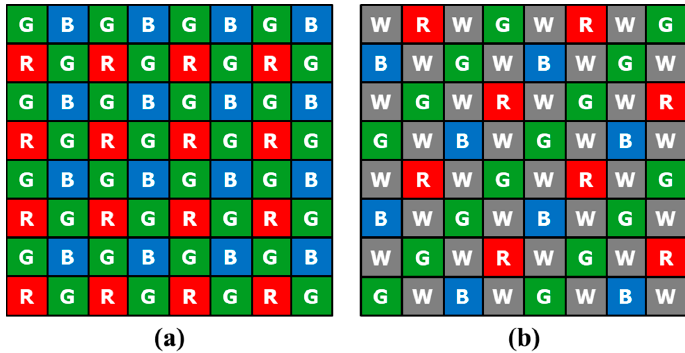
Figure 1. Color filter array (CFA) patterns: ( a ) Bayer [1]; ( b ) Sony red-green-blue-white (RGBW) [2].